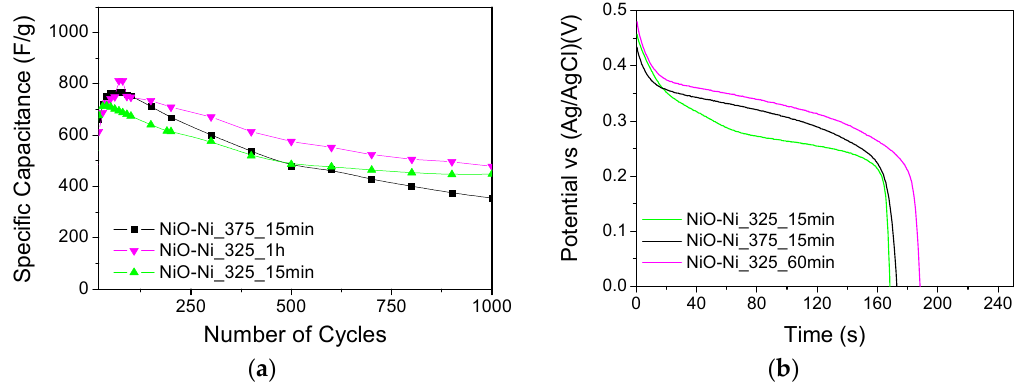
Figure 8. Galvanostatic discharge curves at mA cm − 2 of the different heat treatment electrodes ( a ); and its cyclic chronopotentiometric measurement (CP) ( b ).